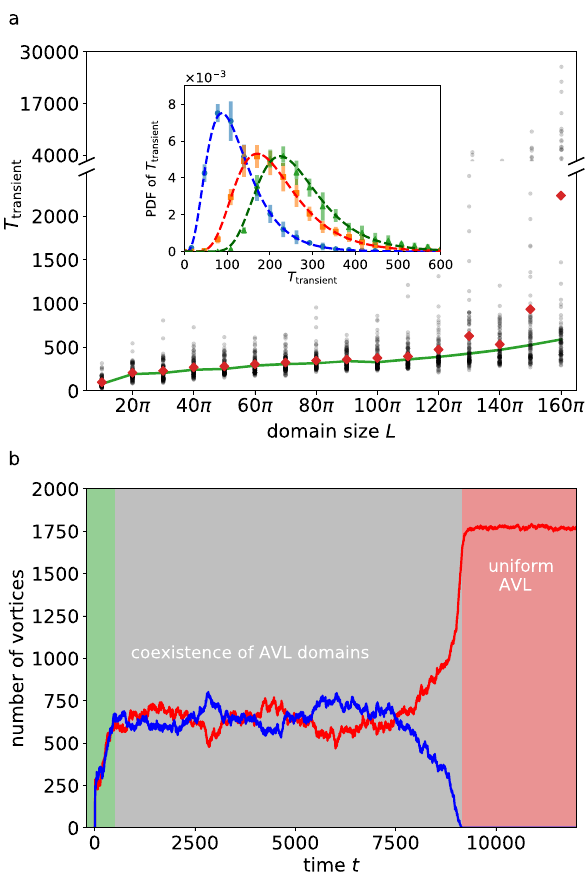
Fig. 4 Transient durations of AVL emergence. ( a ) Scatter plot of the transient durations leading to a uniform AVL domain as a function of domain size L . The red diamonds and the green curve are the mean and median values, respectively. The change in slope at about L = 120 π marks the domain size where AVL domains of opposite polarity start to become stable. (inset) Probability density functions of the transient durations for L = 10 π (blue circles, τ = 54.59, δ = 4.97), 20 π (orange squares, τ = 72.78, δ = 10.40) and 40 π (green triangles, τ = 72.81, δ = 21.67), obtained from 10 4 simulations each, and the corresponding fi ts with the theoretically proposed PDF (4) (dashed curves). The error bars correspond to the difference between the maxima and the minima of fi ve subsampled PDFs (Methods). ( b ) The time series of the number of positive (red) and negative vortices (blue) for a simulation with large domain size ( L = 160 π ). The green, gray, and red regions denote the initial transient, the coexistence of AVL domains of opposite polarity, and the fi nal uniform AVL,